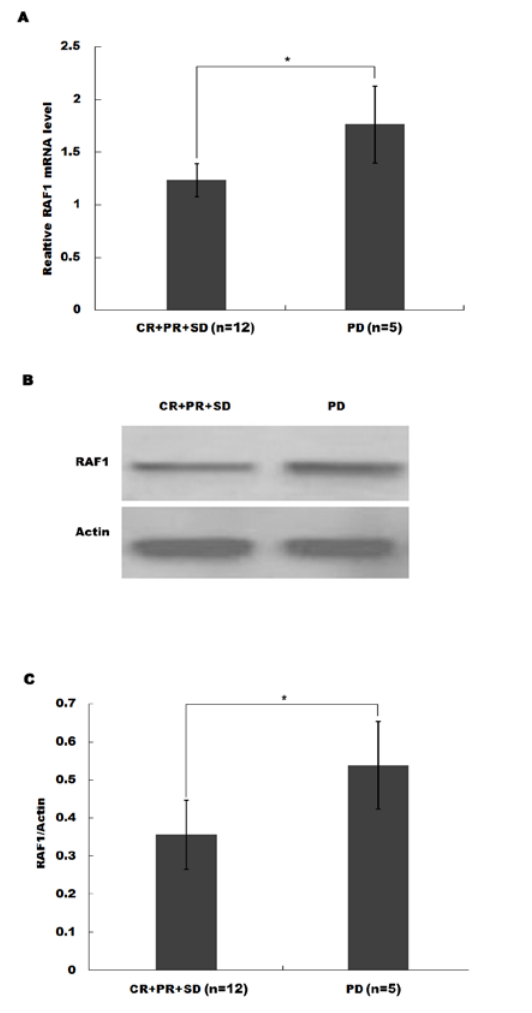
Figure 4: The resistant sub-group (SD) had even higher expression of RAF1 mRNA (A) and protein (B-C) compared to the sensitive sub- group (CR+PR+SD). The HCC patients were divided into four popula- tions according to different responses to sorafenib, which were the complete response (CR) group, the partial response (PR) group, the stable disease (SD) group, and the progressive disease (PD) group. ** p<0.01 HCC vs